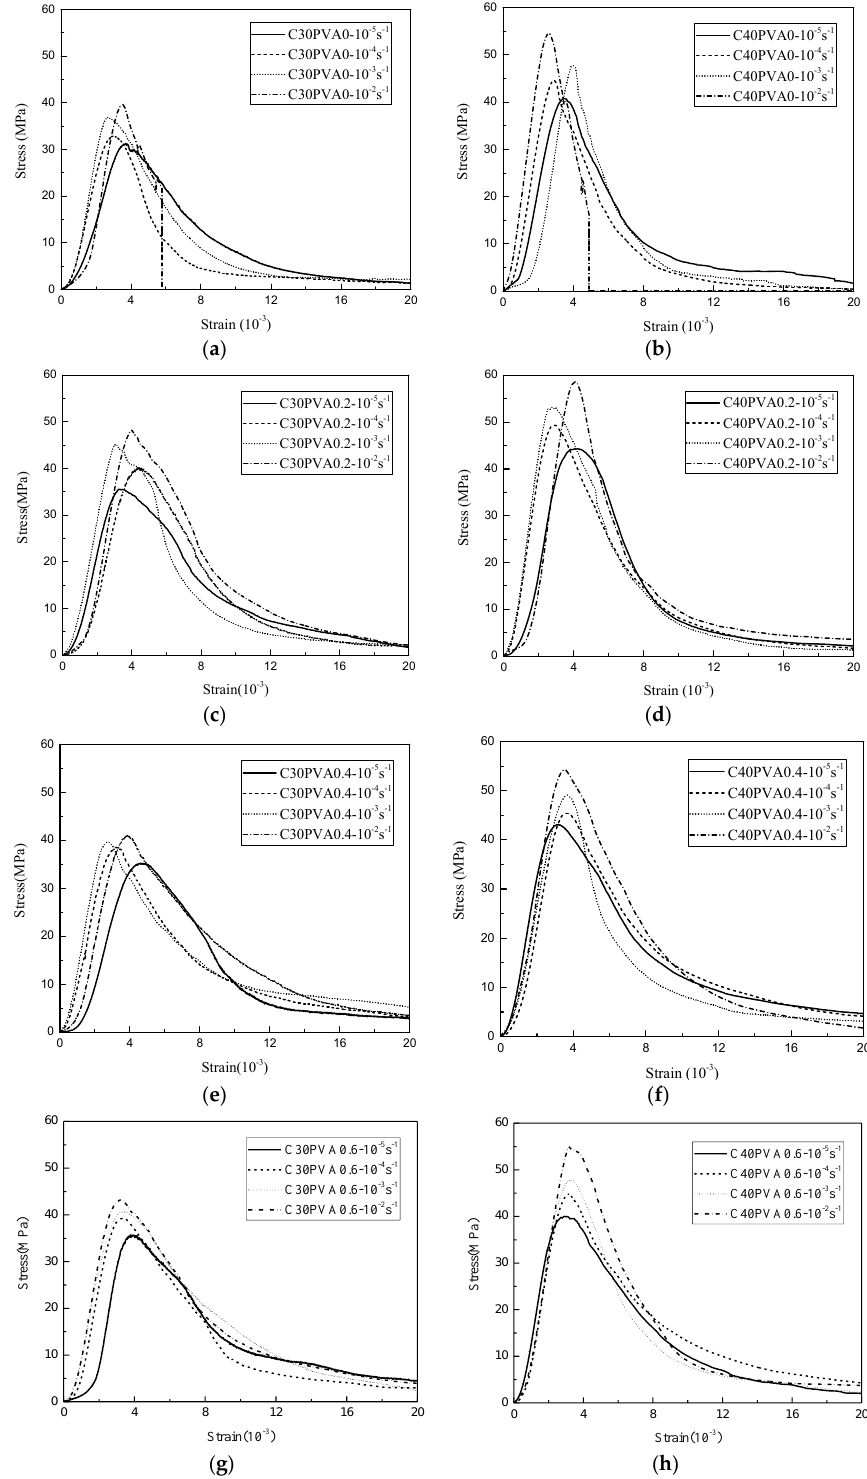
Figure 14. Typical stress–strain curve under different strain rates for ( a ) C30PVA0, ( b ) C40PVA0, ( c ) C30PVA0.2, ( d ) C40PVA0.2, ( e ) C30PVA0.4, ( f ) C40PVA0.4, ( f ) C40PVA0.4, and ( h )